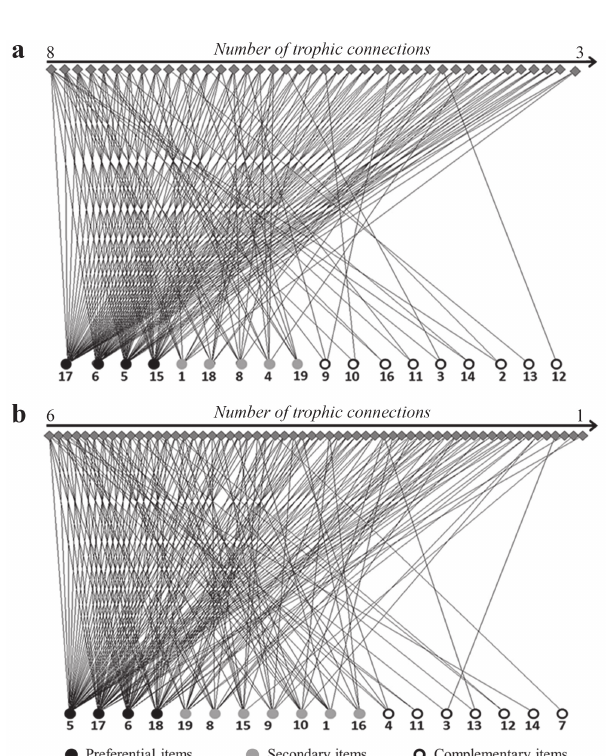
Fig. 4. Individual-resource networks of Gymnorhamphichthys rondoni and Gymnotus coropinae in first to third order streams at the Saracá-Taquera National Forest, Oriximiná, Pará. Full diamonds in the upper portion of the graphs are fish individuals. a. G. rondoni ; b. G. coropinae . Codes: 1 - Arthropoda (T); 2 - Algae; 3 - Aquatic Coleoptera (A); 4 - Aquatic Coleoptera (L); 5 - Ceratopogonidae (L); 6 - Chironomidae (L); 7 - Decapoda; 8 - Diptera (L); 9 - Eggs (Inv); 10 - Ephemeroptera (N); 11 - Hydracarina; 12 - Odonata (N); 13 - Pyralidae; 14 - Scales; 15 - Trichoptera (L); 16 - Zooplankton; 17 - Sediment/Detritus; 18 - Insect remains; 19 - Plant Remains.